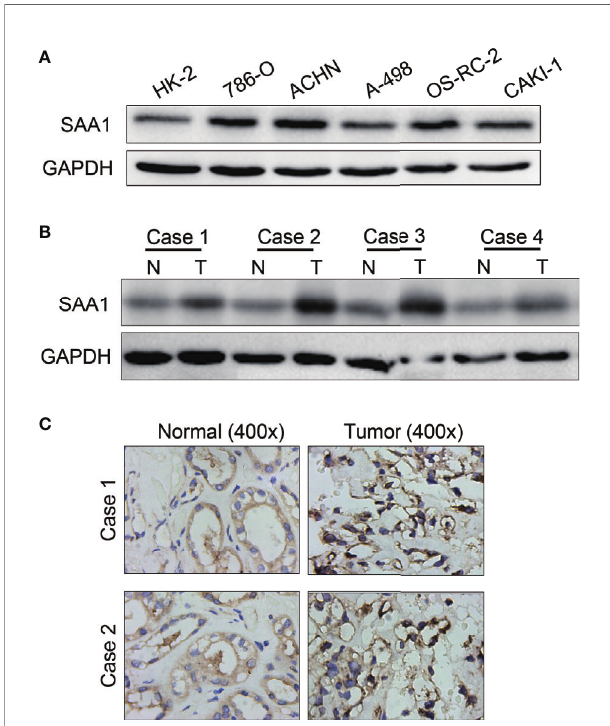
FIGURE 8 | The protein levels of SAA1 in RCC cells and tissues. (A) Western blotting analysis of SAA1 expression levels in RCC cell lines (786-O, ACHN, A-498, OS-RC-2, Caki-1) and renal normal epithelial cells (HK-2). (B) Western blotting analysis of SAA1 protein levels in 4 pairs of ccRCC tissues (N, normal tissue; T, tumor tissue). (C) IHC analysis of SAA1 protein levels in normal renal tissues and ccRCC